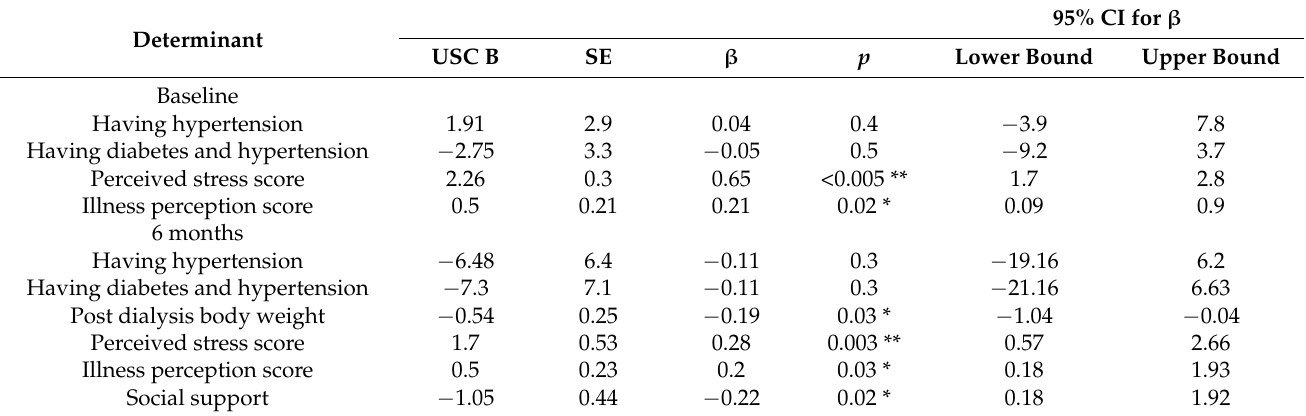
Table 5. Factors associated with symptom burden at baseline ( n = 118) and at 6 months ( n = 102).